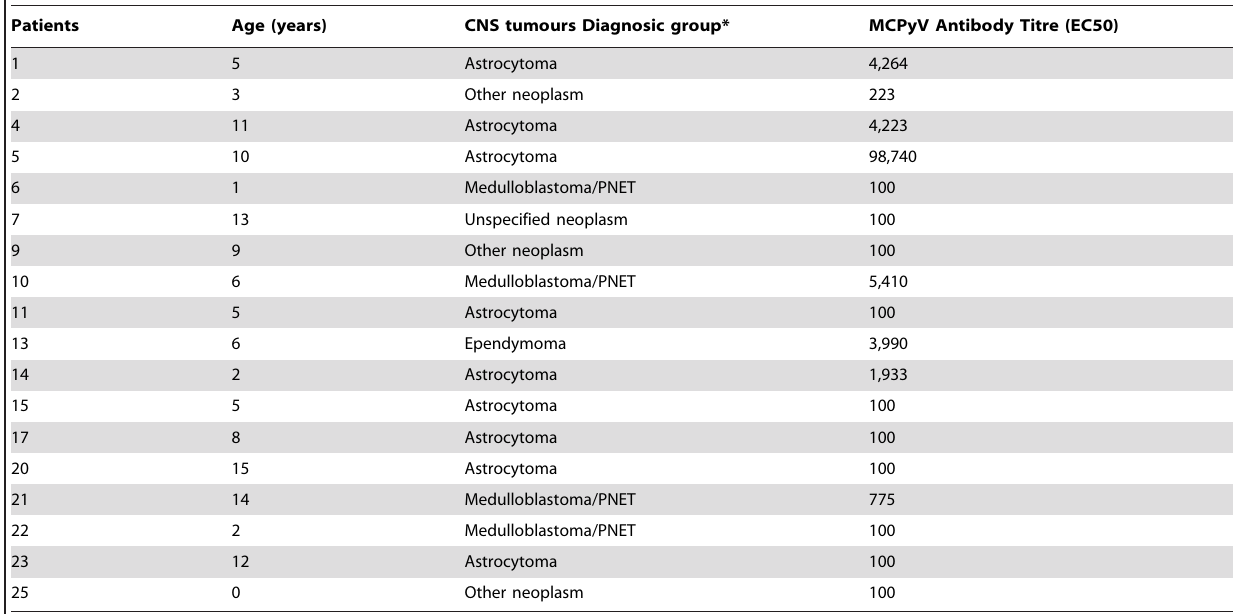
Table 4. MCPyV Serological results from the 18/25 patients with CNS tumours.